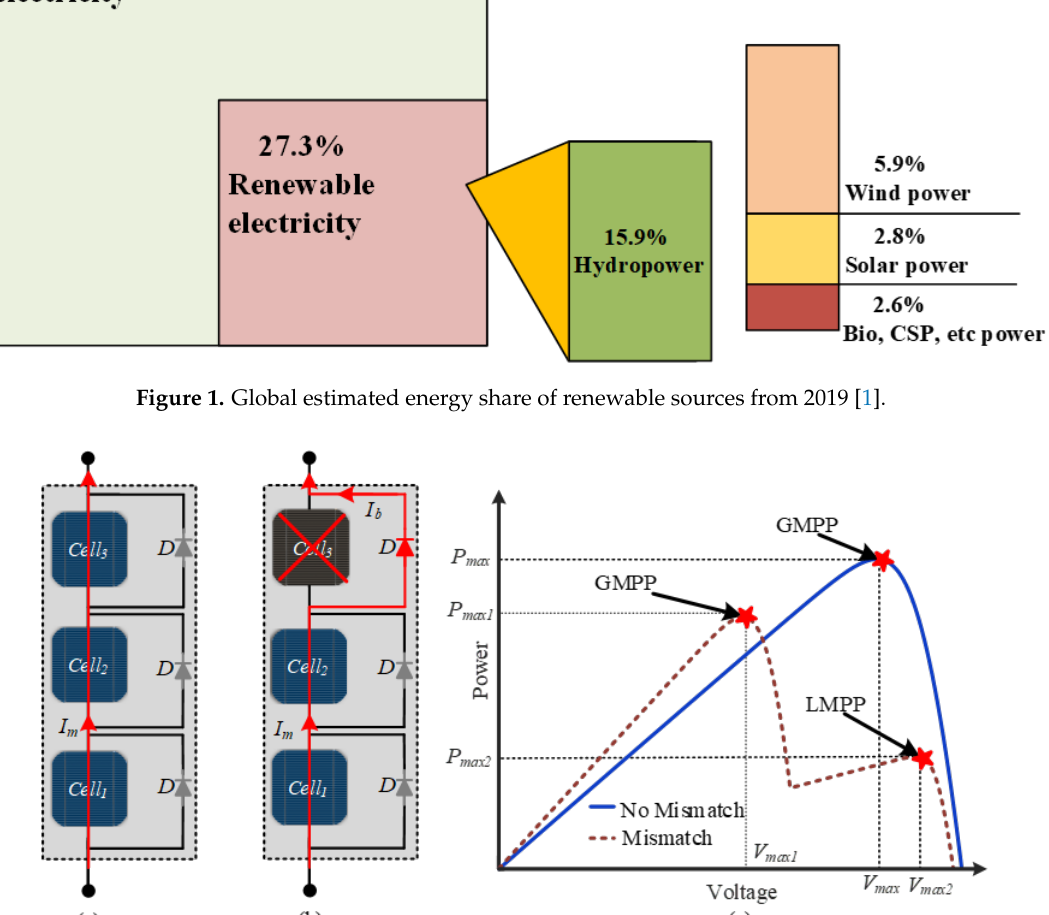
Figure 2. Series-connected photovoltaic (PV) cells (cell1, cell2, and cell3): ( a ) no mismatch or partial shading; ( b ) under mismatch with bypass diode D in ON-state; ( c ) power–voltage (P-V) characteristics under mismatch and no mismatch. Here, Im is PV cell current and Ib is the bypass current passing through the bypass diode.